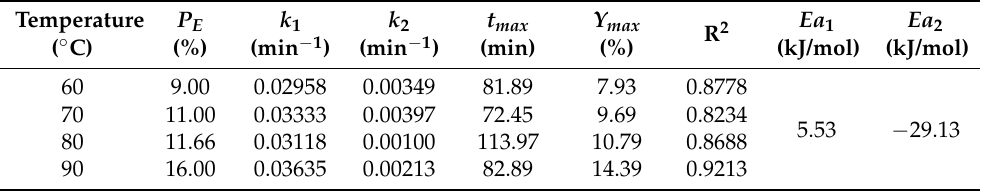
Note: Pe = Total extractable pectin; k = Velocity constant; t max = Extraction time for maximum yield; Y max = Maximum theorical yield; Ea = Activation energy; and R 2 = Correlation coefficient.